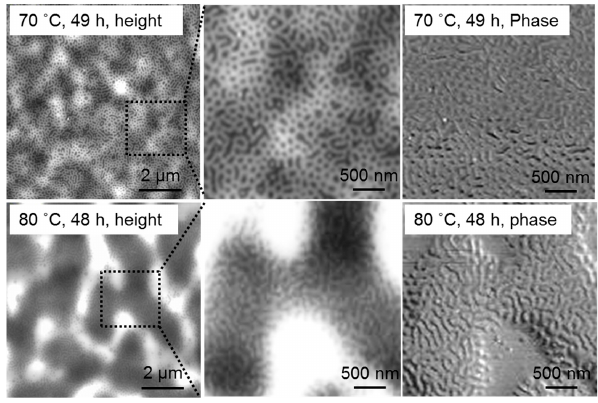
Figure 7. AFM profiles and TEM images of the 80-nm PS- b -P2VP thin films spin-coated at 2500 rpm from 1.5 wt % solution in toluene with further annealing in toluene vapor atmosphere at 70 °C and 80 °C.